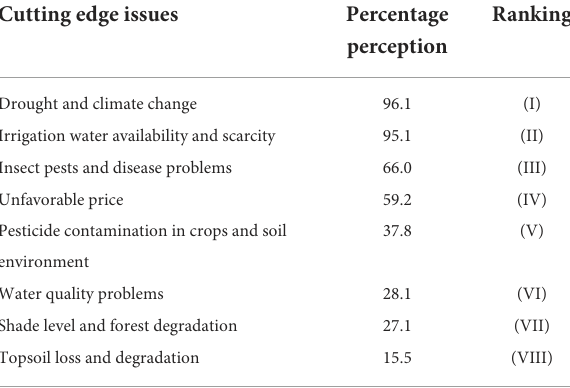
TABLE 3 Planters’ perception on the cutting-edge issues including drought and climate change affecting sustainability of cardamom farming ( n =